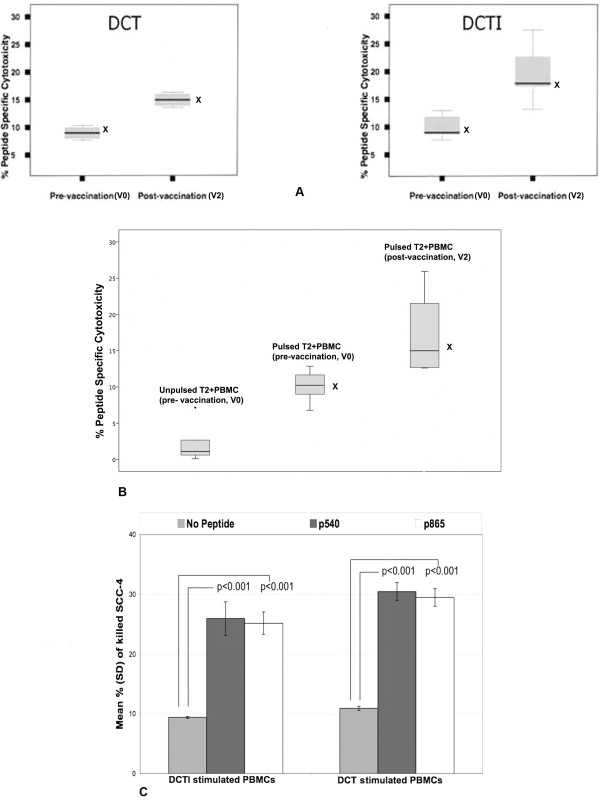
A. Cytotoxicity against peptide-pulsed T2 cells before and after 2 cycles of vaccination (N001–N010, phase I). Enhanced cytotoxicity before and after 2 cycles of vaccination with peptide-labelled T2 cells. Graph on the left shows cytotoxicity of PBMCs generated using DCT vaccine, that on the right shows cytotoxicity of PBMCs generated using DCTI vaccine; 10,000 PKH-labelled T2 events were acquired and analysed. Statistically significant cytotoxicity was observed following 2 vaccinations compared with baseline (X: p = 0.04, Wilcoxon signed rank test). Values are represented as median (bar), interquartile range (box) and range (whiskers). B. Cytotoxicity against peptide-pulsed T2 cells before and after 2 cycles of vaccination (L001–L006, phase II): Cumulative cytotoxicity (mean, SD) before and after 2 cycles of vaccination with peptide labelled T2 cells at an effector to target cell ratio of 10:1. Unlabelled T2 cells were used as a negative control; 10,000 PKH-labelled T2 events were acquired and analysed. Statistically significant cytotoxicity was observed following 2 vaccinations compared with baseline (X: p = 0.028, Wilcoxon signed rank test). Values are represented as median (bar), interquartile range (box) and range (whiskers).C. SCC-4 targeted ex vivocytotoxicity of PBMCs (N001–N007, phase I): Cumulative cytotoxicity of T cells generated by 3 re-stimulations of naïve patient PBMCs in vitro by DCT & DCTI with p540, p865 or no peptide; 10,000 SCC-4 cells were incubated with 100,000 PBMCs for this assay.10,000 PKH+SCC-4 events were acquired and analysed. Results are represented as mean (SD). Statistically significant SCC-4 cytotoxicity was observed with DCT and DCTI re-stimulated PBMCs compared with PBMCs restimulated without the class I peptides (X: p < 0.001, t-test), thus showing evidence of cytotoxicity against naturally processed hTERT peptides of SCC-4.